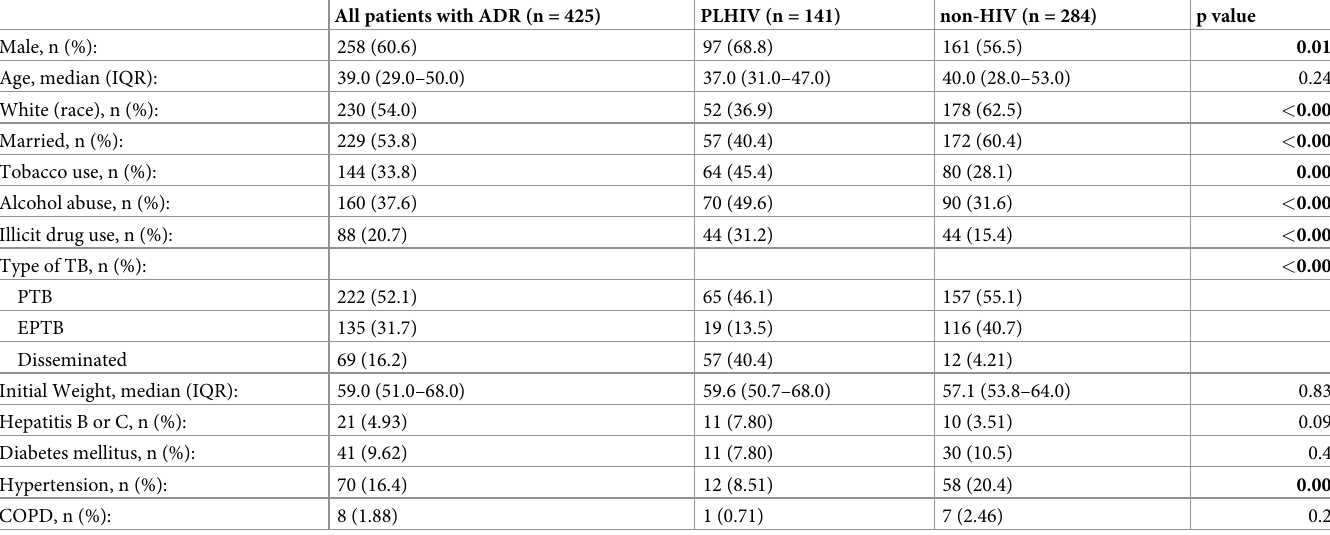
Table 3. Sociodemographic and clinical characteristics of patients who presented ADR according to HIV status. All patients with ADR (n = 425) PLHIV (n = 141) non-HIV (n = 284)